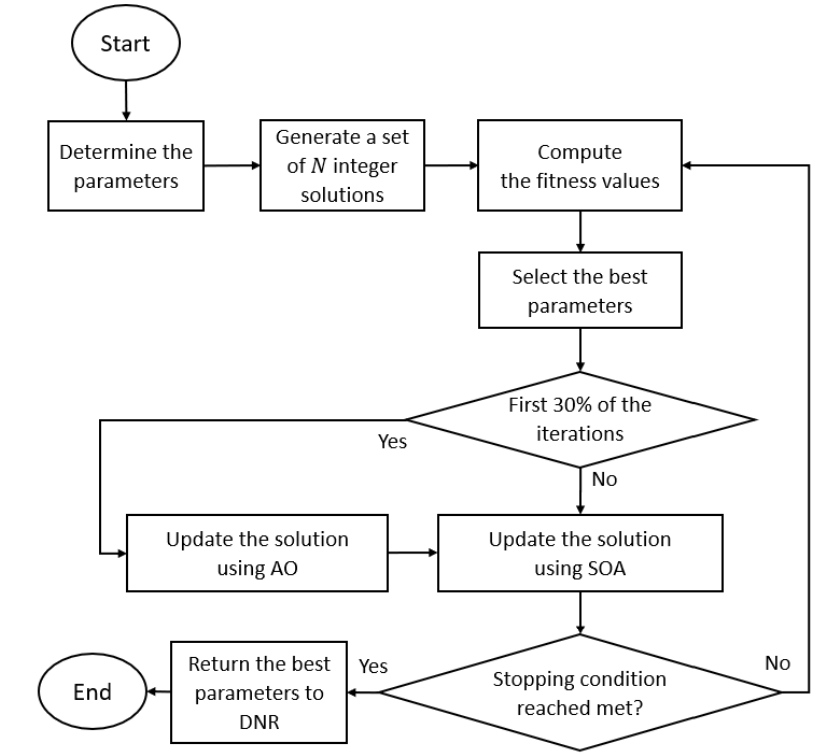
Figure 1. The proposed method.